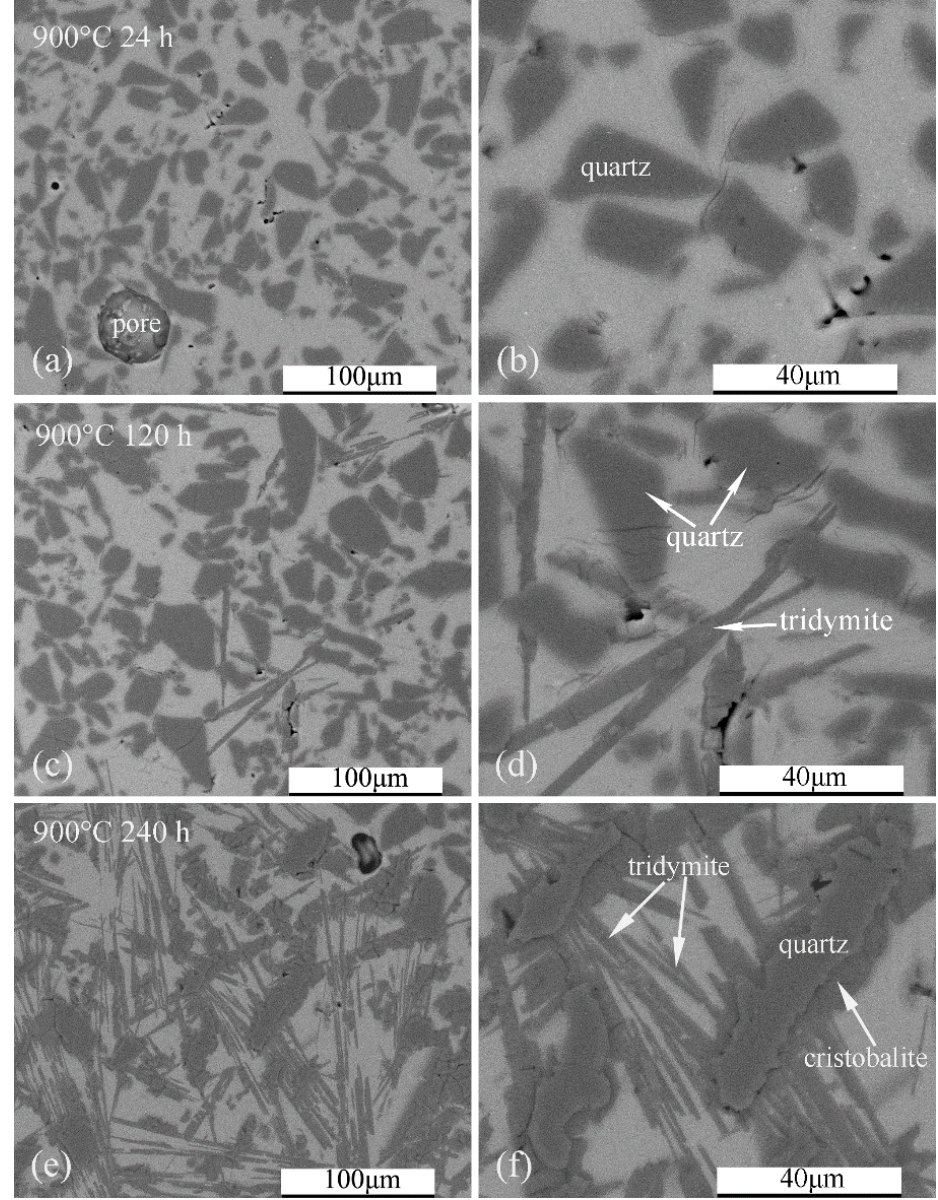
Figure 8. Microstructure of the coarse quartz—potassium silicate glass composites after holding at 900 °C for different time: 24 h ( a , b ), 120 h ( c , d ) and 240 h ( e , f ).